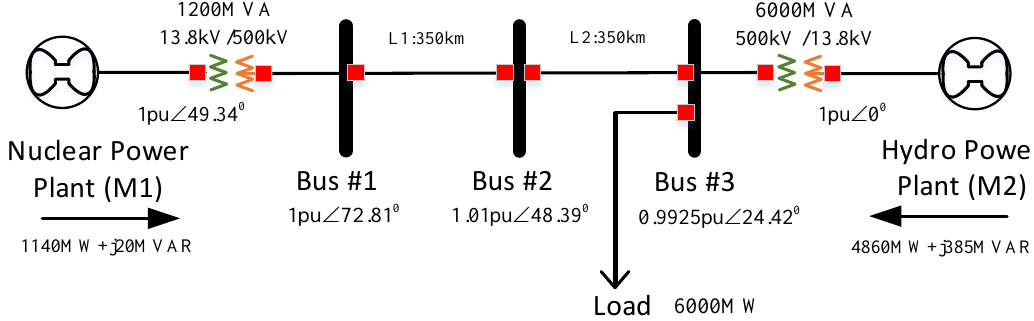
Figure 7. Network model of an electric